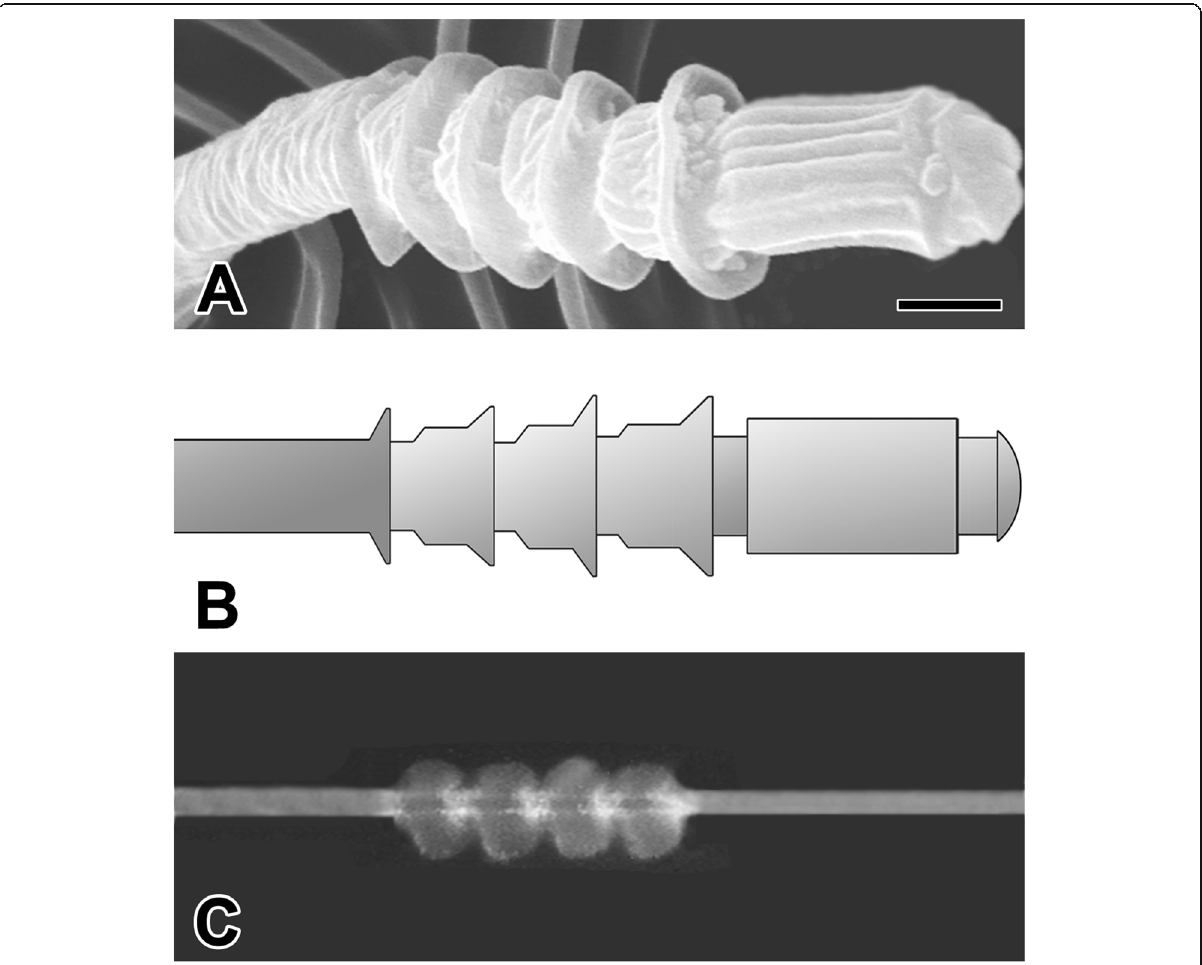
Fig. 6 a Scanning electron micrograph of the cribellate spigots in N. albofasciata . The cribellate spigots are composed of five tubal segments with four thicker regions which will provide the characteristic pearling node of the cribellate threads. b Diagram of the cribellate spigot which composed of five tubal segments with for thicker regions. c Photo micrograph of the cribellate silk line. Each silk line has a unique outer morphology resembling the segmented insulators since the silk filaments are spun out from the spigot by the rapid hackling. Scale bar indicates 0.5 μ